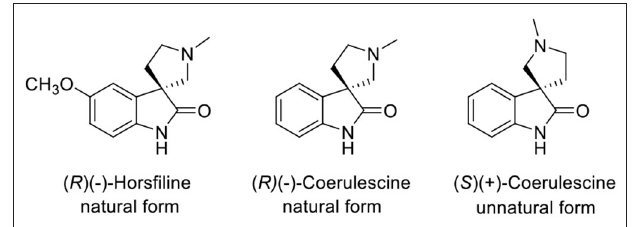
FIGURE 1 | Structures of horsfiline and coerulescine.